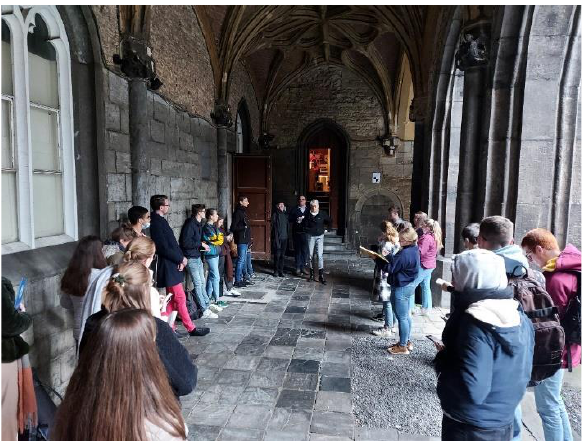
Figure 9. Students at work in the cloister of Saint John collegiate church. Picture by author.